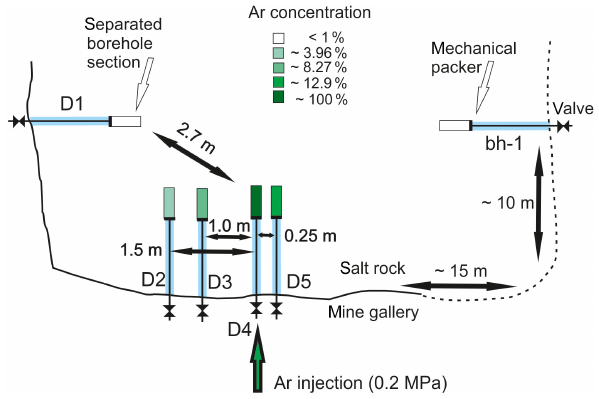
Figure 1. Plane view of the boreholes D1 to D5 in Seam Hessen (z1KHe) with average Ar concentrations and distance to the injec- tion hole as well as the isolated pristine borehole bh-1 (dimensions are not in true